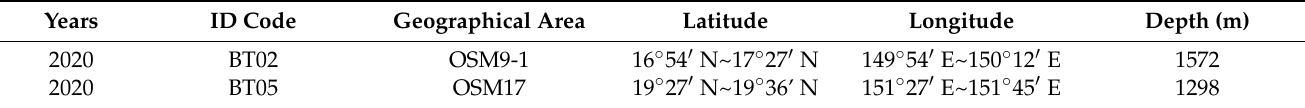
Table 1. List of samples and collection locations.